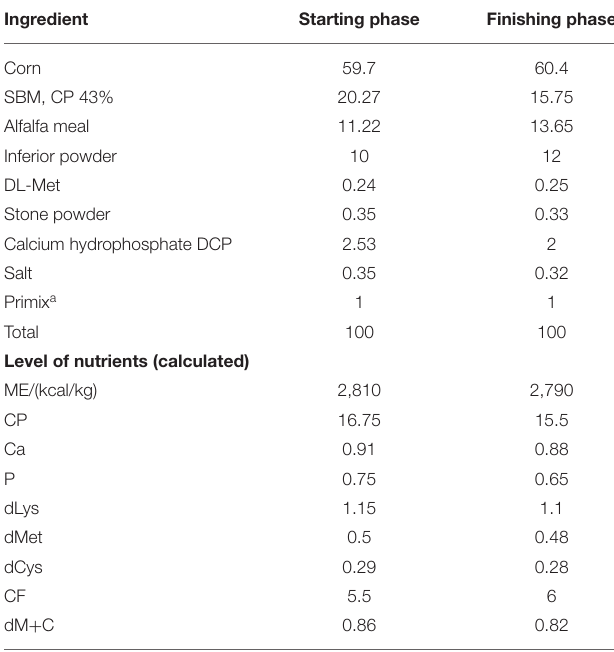
TABLE 1 | Composition of the experimental diets for